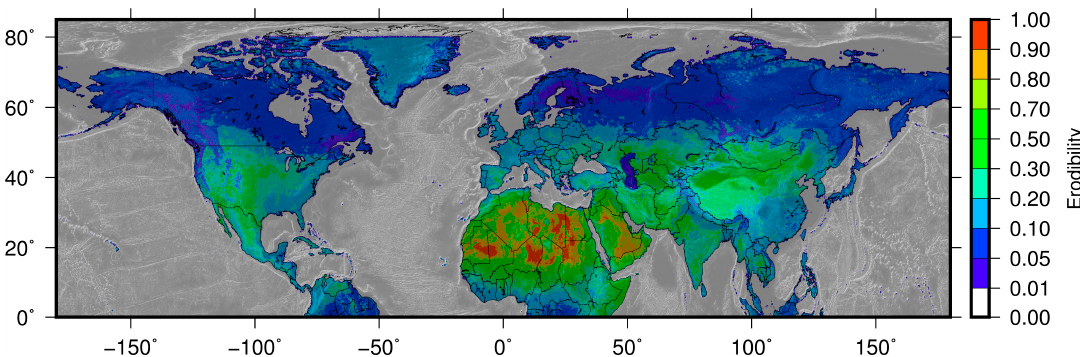
Figure 1. Erodibility map used in CHIMERE for this study (with black and white topographic background).